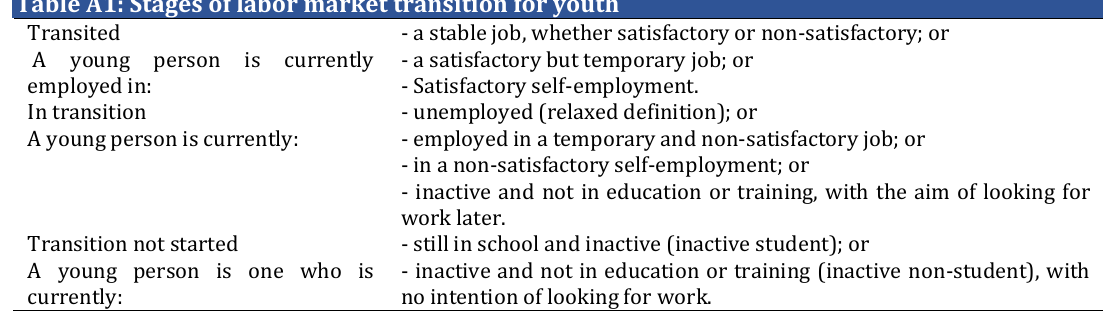
Table A11: Kaplan – Meier Survival analysis of unemployment duration: Method